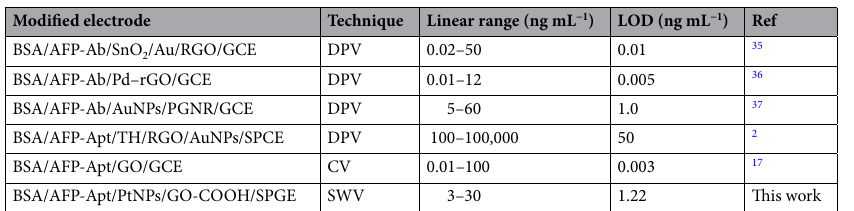
Table 1. Comparison of the analytical performance of different label-free electrochemical immunosensors for AFP detection. Ab antibody, Apt aptamer, Pd–rGO palladium–reduced graphene oxide, PGNR porous graphene nanoribbon, TH/RGO/AuNPs thionin/reduced graphene oxide/gold nanoparticles.